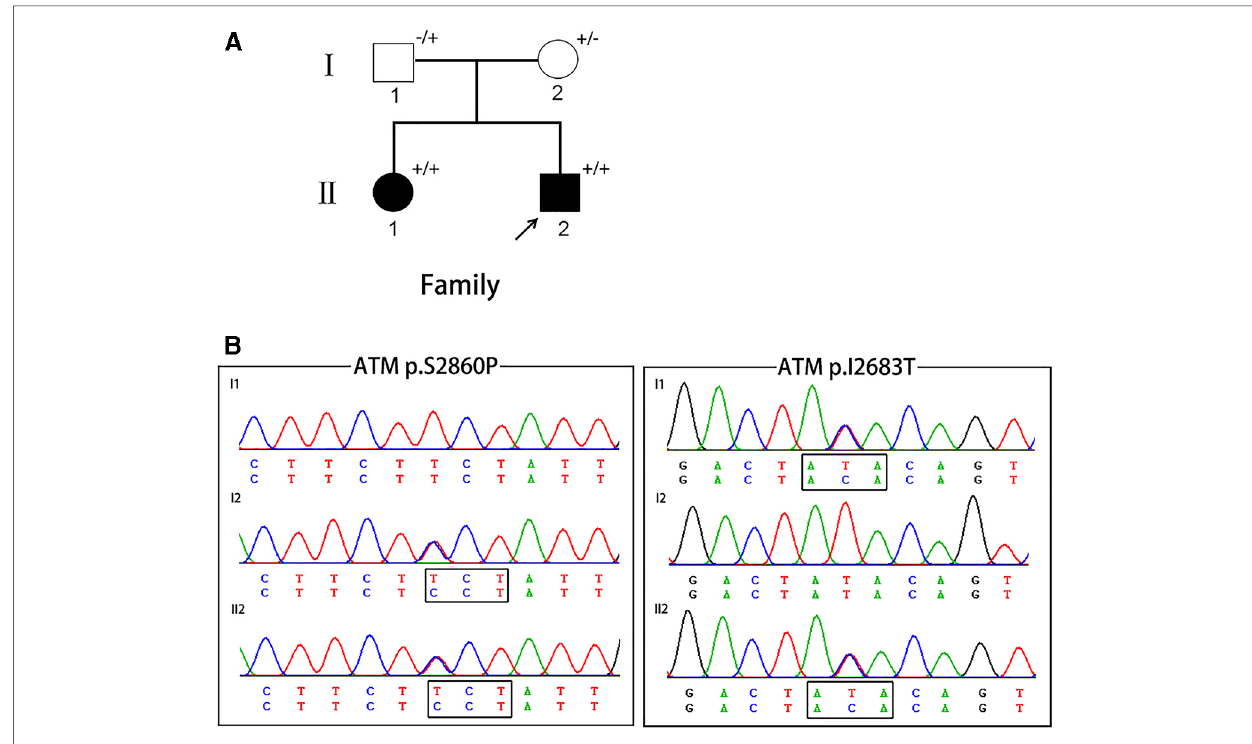
FIGURE 1 ( A ) The pedigree of A-T patients in present study. Squares indicate males; circles indicate females; fi lled symbols indicate affected individuals; arrows indicate the probands; “ +/+ ” indicate two mutant alleles; “ +/ − ” or “ − /+ ” indicate mutation occurring in one of two alleles. ( B ) Chromatograms of the proband and the proband ’ s